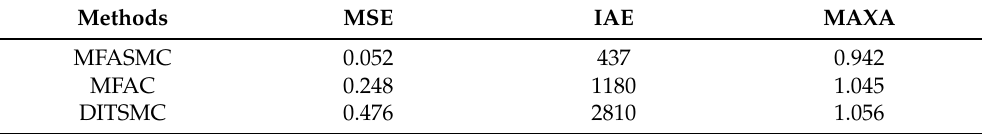
Table 2. Comparison of several performance indexes of each control